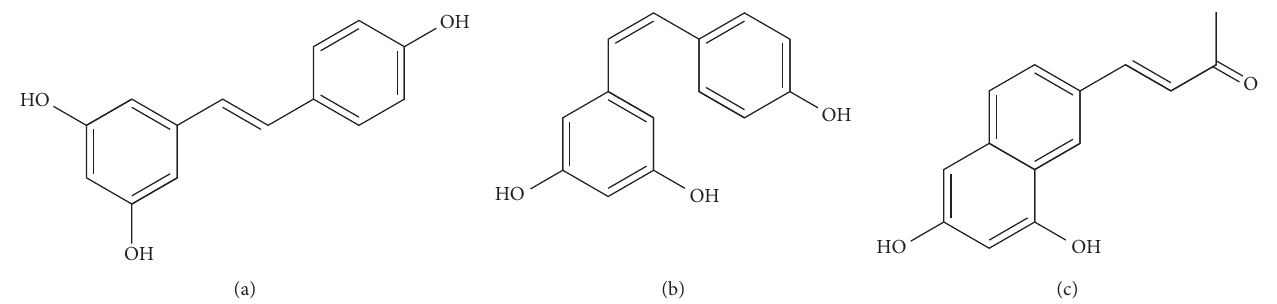
Figure 1: Chemical structure of compounds: trans -resveratrol (a), its isomer, cis -resveratrol (b), and its reported degradation product, resveratrone